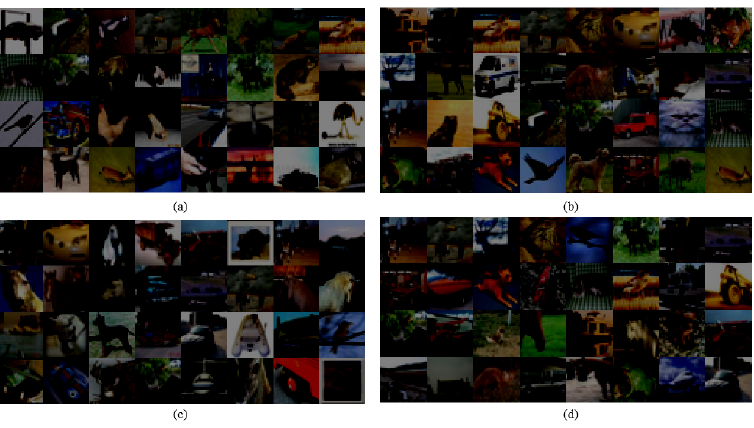
Figure 10. ( a – d ) Images in CIFAR10 with large DSA values.